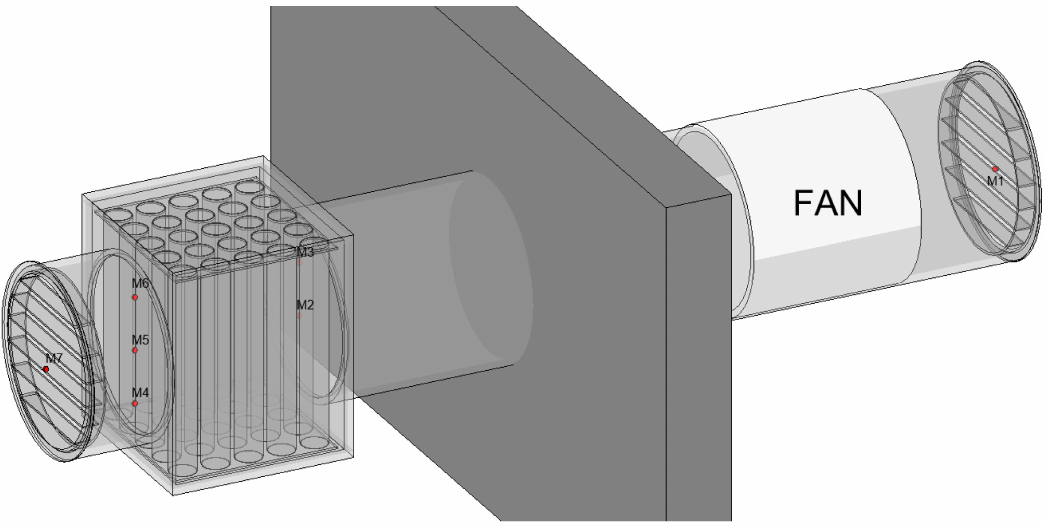
Figure 11. Diagram of the arrangement of measuring points (thermocouples).